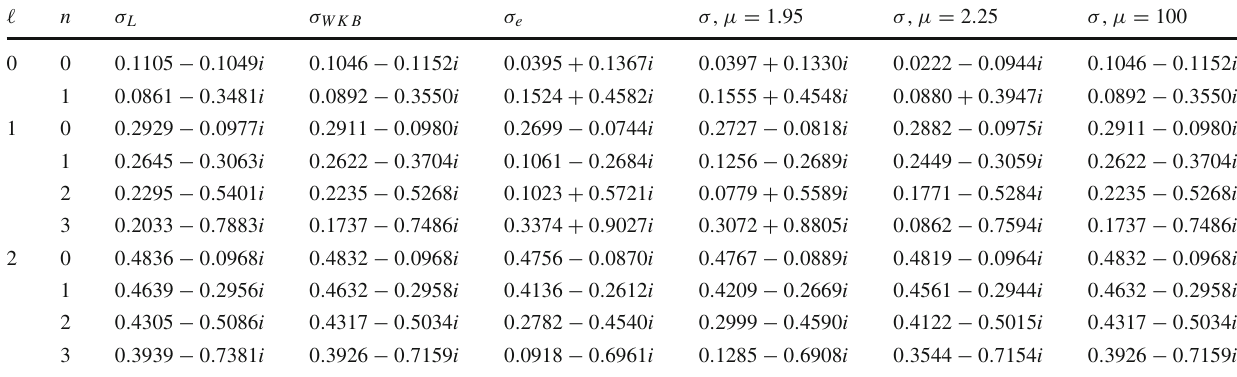
Table 1 Normal modes for scalar perturbations of the noncommutative geometry inspired Schwarzschild metric. The third column represents thenumericalvaluesfoundby[50]inthecaseofaclassicSchwarzschild black hole while the fourth columns reports the corresponding WKB